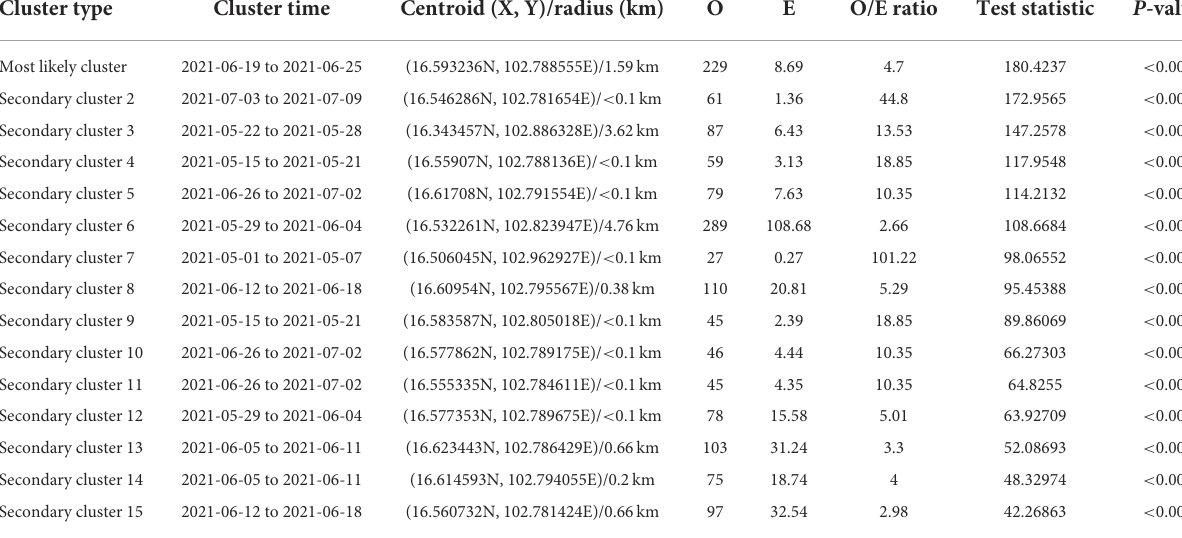
TABLE 1 Spatio-temporal analysis of lumpy skin disease outbreaks in dairy farms, Khon Kean province, Thailand by space-time permutation